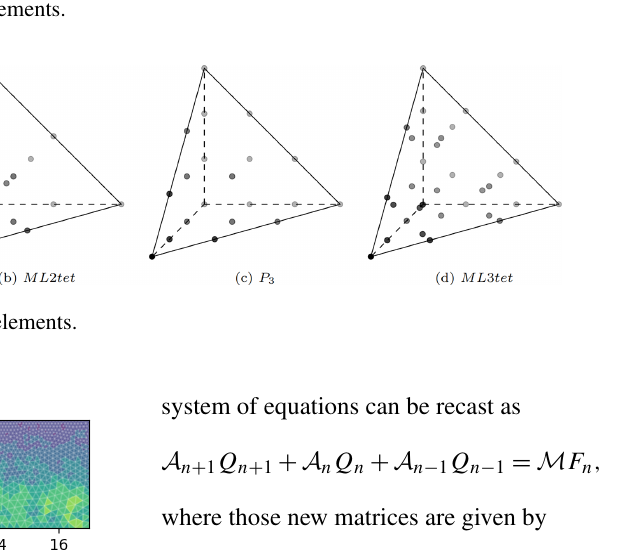
Figure 2. Some two-dimensional Lagrange and ML elements.